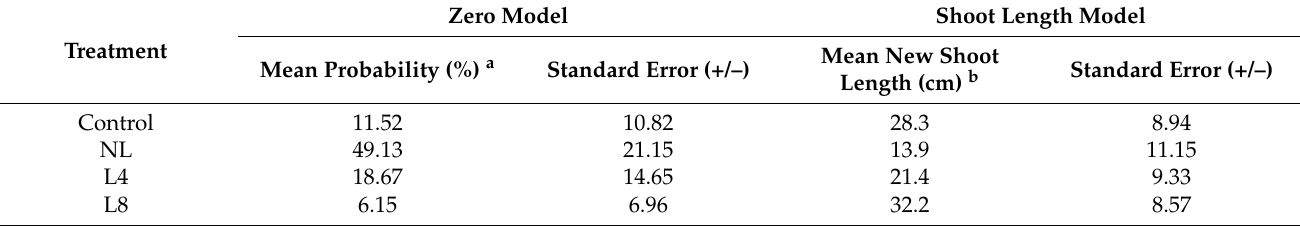
Table 4. Zero-inflated linear mixed model analysis on the effect of treatment on new shoot growth production and new shoot growth